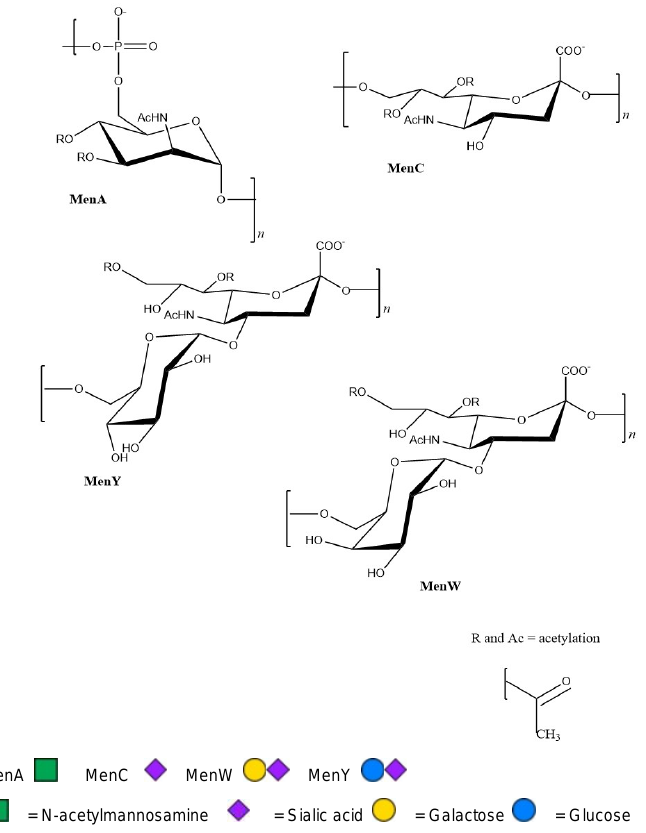
Figure 1. Chemical structures of monosaccharide units of meningococcal polysaccharides for which there are currently glycoconjugate vaccines. Sites of potential O-acetylation is indicated by R groups. The monosaccharide symbols follow the Symbol Nomenclature for Glycans (SNFG) according to [49].